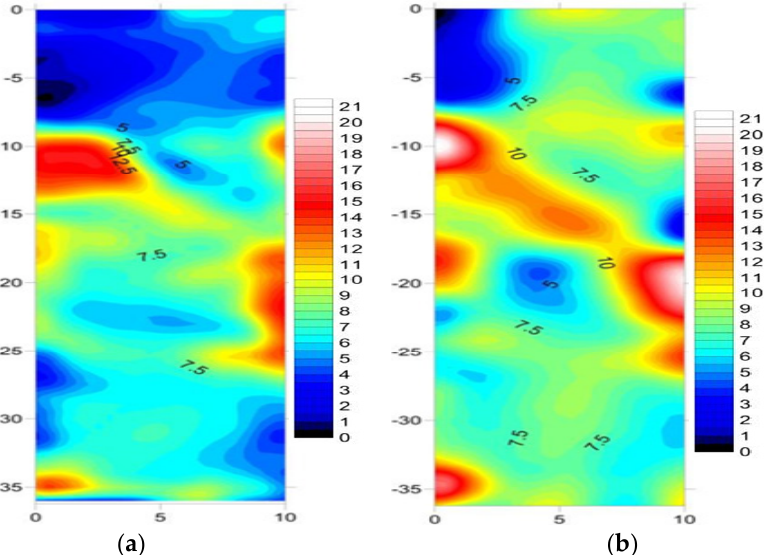
Figure 12. Comparison of electromagnetic wave CT detection results before and after hydraulic fracturing; ( a ) Before hydraulic fracturing roof cutting; ( b ) After hydraulic fracturing roof cutting.